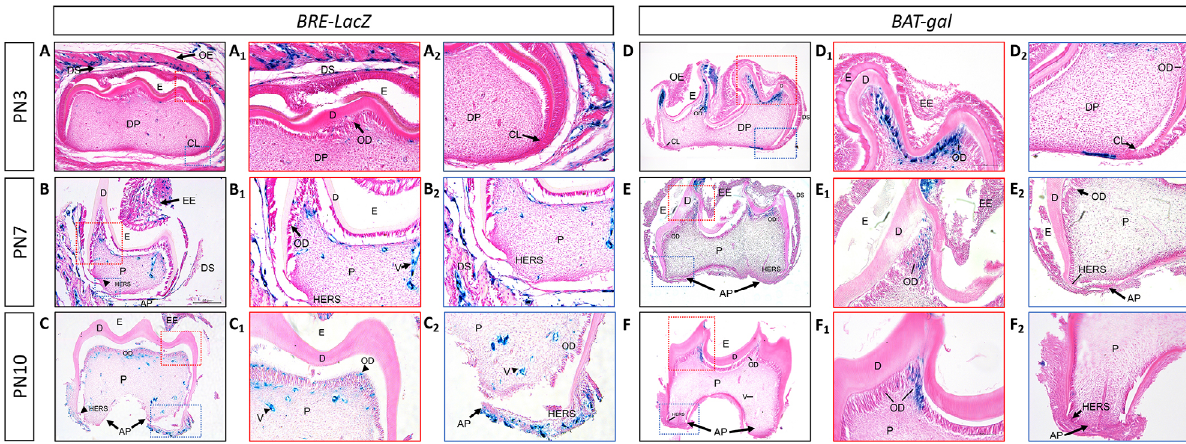
Figure 3- Selected histological sections of postnatal M1 with whole-mount X-gal staining at 10 µm thickness. Localization of active BMP/ Smad signaling (A, B, and C, ×40) and Wnt/β-catenin signaling (D, E, and F, ×40) in M1 is shown. Panels A1, B1, C1, D1, E1, and F1 are high-magnification views (×100) of the red rectangular block as shown in panels A, B, C, D, E, and F, respectively. Panels A2, B2, C2, D2, E2, and F2 are high-magnification views (×100) of the blue rectangular block as shown in panels A, B, C, D, E, and F, respectively. On PN3, BMP/Smad-dependent signaling was primarily detected in the dental epithelium (A, A1, and A2); whereas active Wnt/β-catenin signaling was mainly expressed in the odontoblasts or pre-odontoblasts below the cusps and in the dental epithelium on the cusps; some expression was found in the apical region (D, D1, and D2). On PN7, BRE activity was detected in the pre-odontoblasts/odontoblasts in the crown pulp, blood vessels, and DAC (B, B1, and B2); Wnt/β-catenin activity was observed below the cusps, but none in the dental papilla and sac, nor in the vessels in the pulp (E, E1, and E2). On PN10, the same expression pattern was identified, associated with significant root elongation and advanced tooth mineralization (C, C1, and C2). Meanwhile, in BAT-gal mice, the number of X-gal-positive cells beneath the cusps decreased on PN10 (F, F1, and F2). (EE, enamel epithelium; OE, oral epithelium; DS, dental sac; CS, cusp; C, crown; R, root; DP, dental papilla; AP, apical papilla; P, pulp; CL, cervical loop; E, enamel; D, dentin; OD, odontoblast; V, vessel;